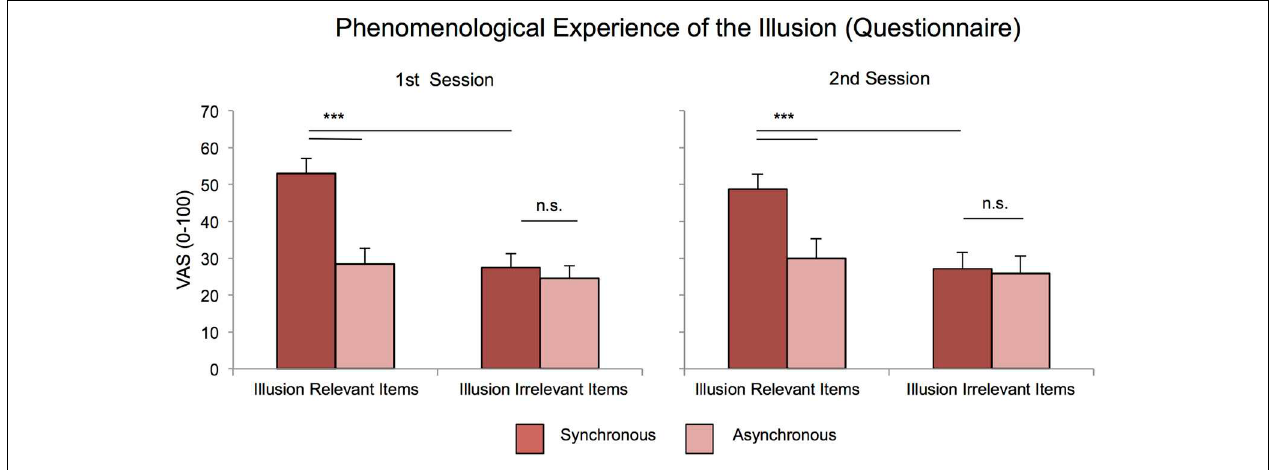
FIGURE 2 | Explicit measures of enfacement. At the explicit level, participants reported higher scores after synchronous with respect to asynchronous stroking only in the items describing the experience of the illusion, in both sessions and independently of group membership and interpersonal manipulation. Agreement scores